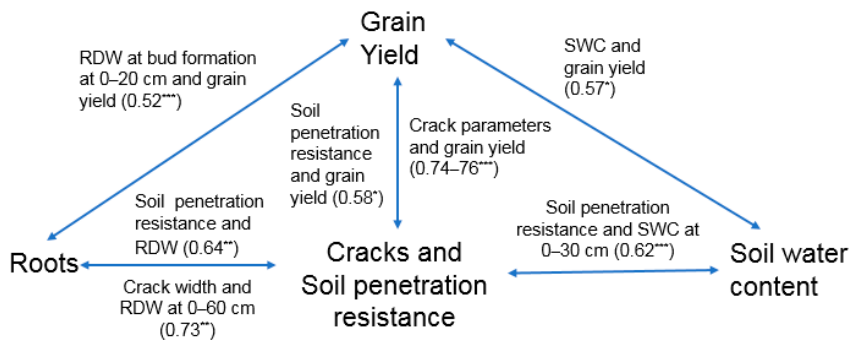
Figure 10. Schematic diagram summarizing the best relationships between the various factors studied in this paper. Values in the brackets indicate the r 2 and significance of the simple linear regression between the two named variables. RDW = root dry weight; SWC = soil water content. * ** and *** indicate significance at 5%, 1% and 0.1% probability level. NS = non-significant.